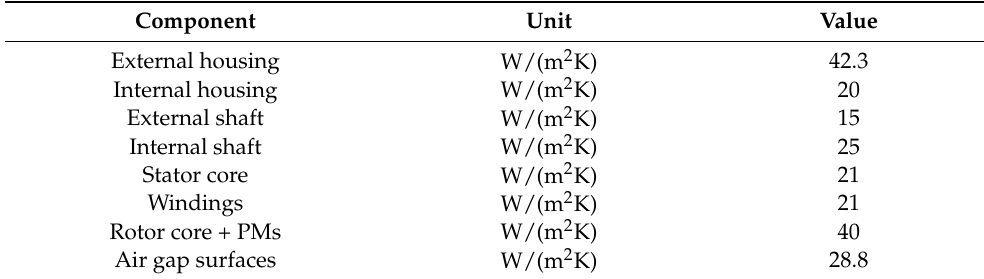
Table 8. Heat transfer coefficients of the machine’s surfaces.